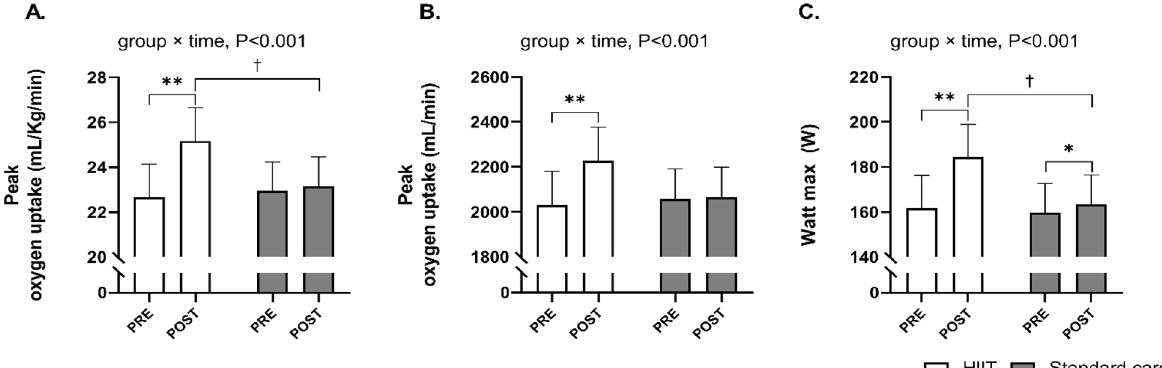
Figure 3. Values are presented as means (with 95% confidence intervals) from a linear mixed-model with group, time, and group × time interaction as fixed factors. The figure shows peak oxygen uptake measured pre- and post-intervention ( A,B ) and peak workload measured pre- and post-intervention ( C ). If a significant effect of group × time interaction existed, the result of the post hoc analysis is indicated by *P < 0.05, **P < 0.001 compared with pre-intervention, and † P < 0.05 compared with standard